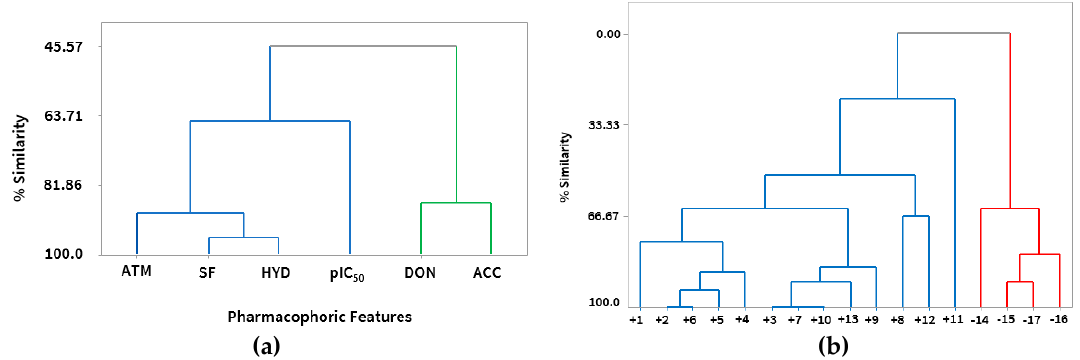
Figure 4. ( a ) Dendrogram of hierarchical clustering analysis (HCA), correlation between pharmacophoric characteristics and pIC 50 . ( b ) Dendrogram (HCA) of structures classified as more active in blue and less active in red.